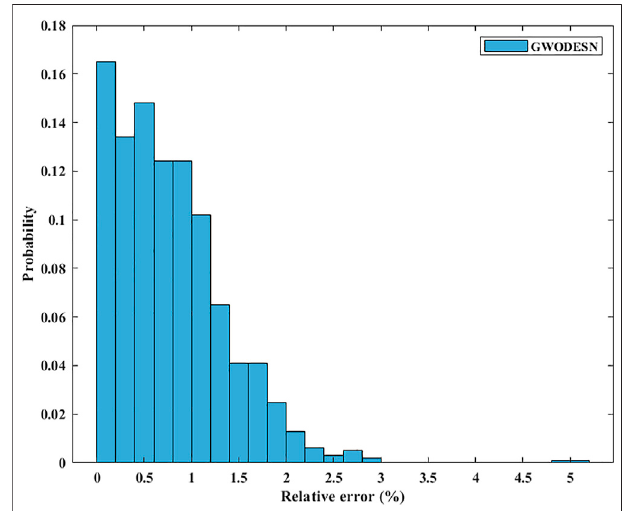
FIGURE 13 | Relative error distribution for CCPP.